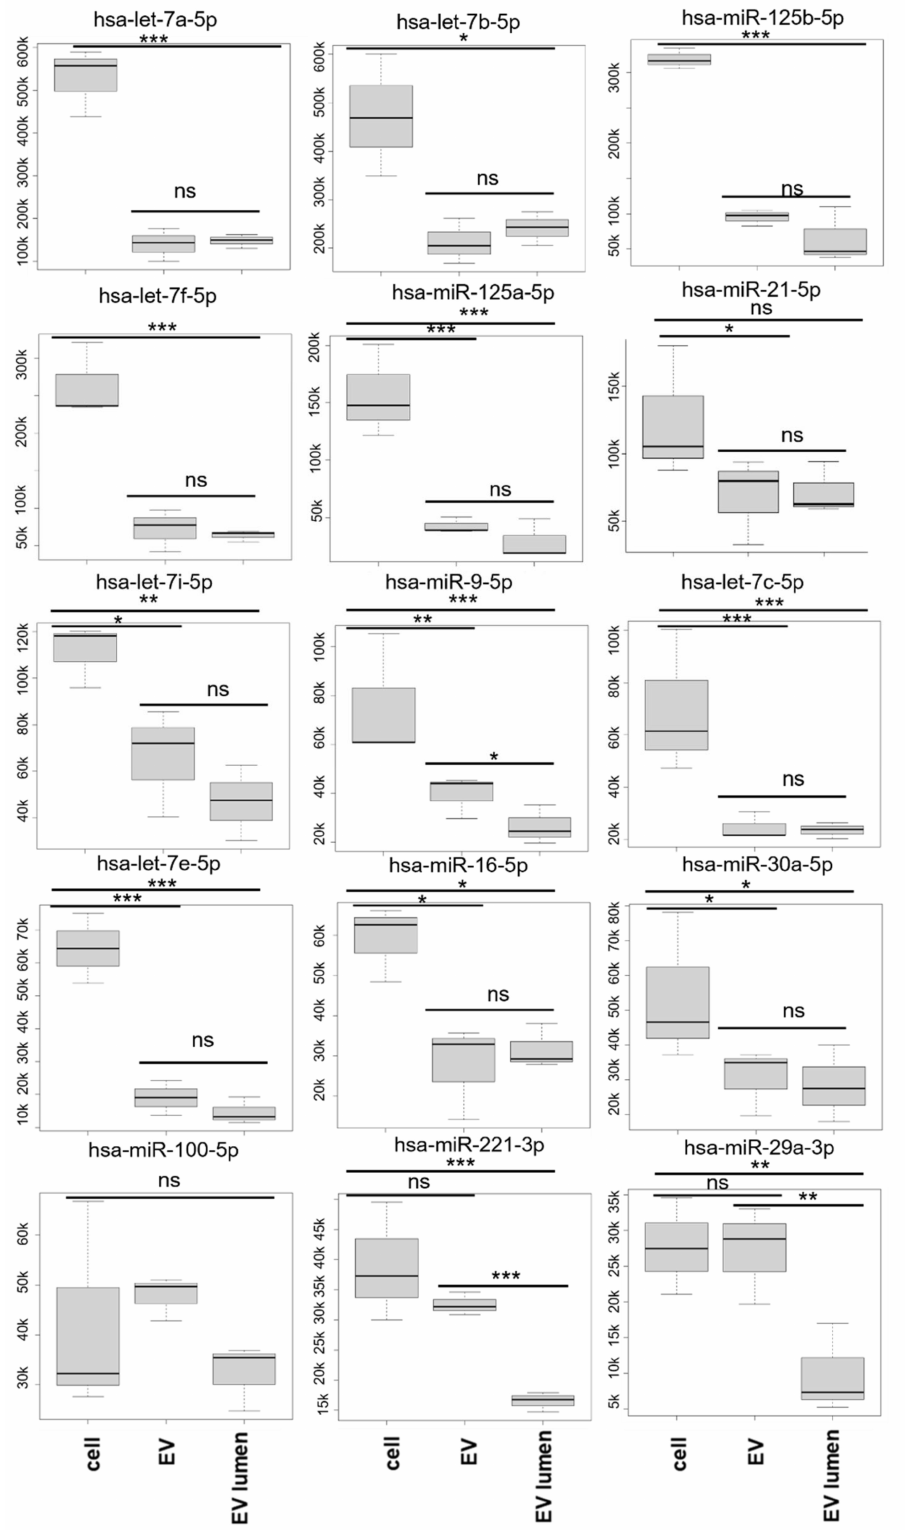
Figure 8. The 15 most abundant miRNAs in cells ordered from most to least abundant in cells. Mean TMM ± SD values. These miRNAs were used for the GO